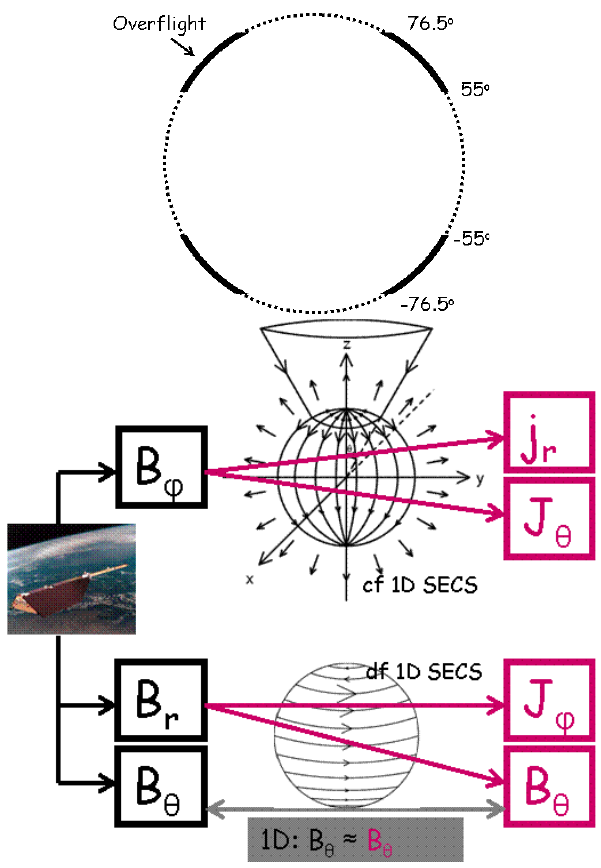
Fig. 1. Left: Division of one orbit into four overflights between 55 ◦ ... 76 . 5 ◦ and − 76 . 55 ◦ ... − 55 ◦ MAG latitude. Right: Determi- nation of the ionospheric current density ( j r , J θ , J φ ) from the mag- netic field measured by a satellite ( B r , B θ , B φ ) using the 1-D SECS method (picture of CHAMP: courtesy of http://www.gfz-potsdam.